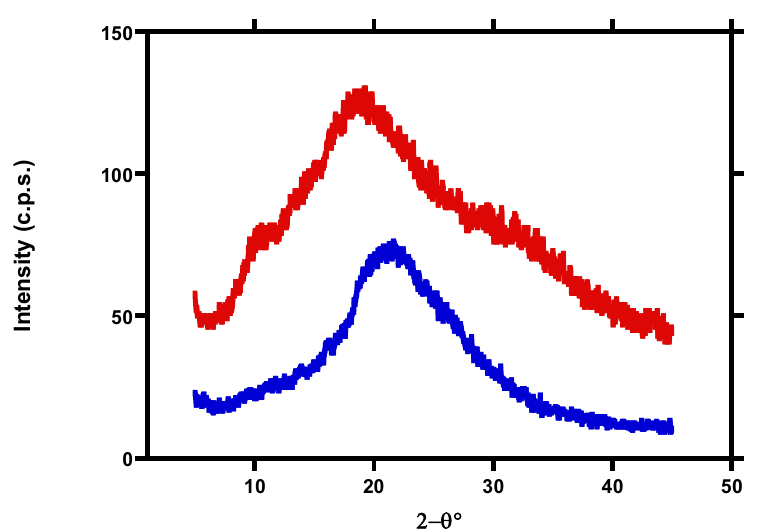
Figure 6. Powders XRD of POP (blue line) and Re@POP (red line). Further SEM analysis was performed, while at medium magnification, 2 µ , differences between POP and Re@POP remain feeble (Figure S9), as shown in supplementary materials, high magnification reveals some differences showing the ultimate morphological details; in Figure 7 both samples are shown, they are characterized by porous aspect with significantly different globular features, namely Re@POP1 display smaller aggregates compared to Re@POP2 , typically from 10–20 nm up to 30–50 nm, respectively. This observation can be promptly related to different absorption properties (see